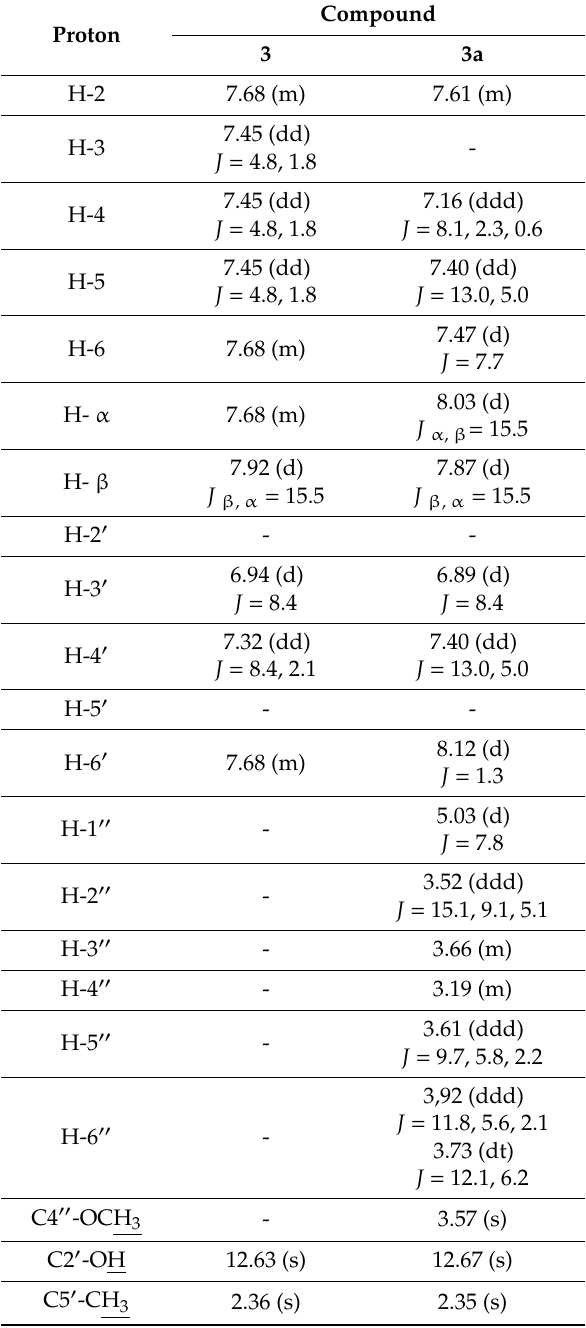
Table1. 1 H-NMRchemicalshifts δ (ppm)andcouplingconstants J (Hz)of2 (cid:48) -hydroxy-5 (cid:48) -methylchalcone ( 3 ) in Chloroform-d, and product of its biotransformation 3a in Acetone-d6, 600 MHz (Supplementary